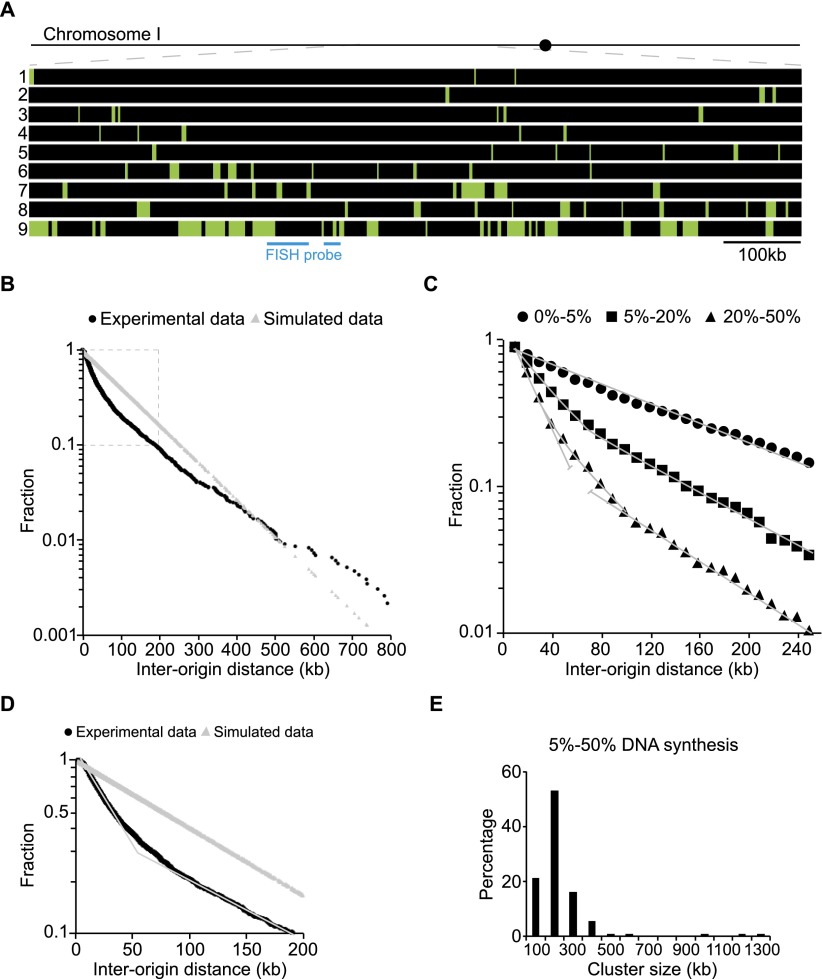
Replication origins both fire stochastically and form clusters. (A) Replication profile of nine completely overlapping 1-Mb single DNA molecules corresponding to the same region on Chromosome I (from 2100 to 3100 kb). (B) Semilog plot of the cumulative frequency of IODs measured for 131 single DNA molecules with an average length of 1.8 Mb and replicated up to 50% (black curve). The values on the y-axis correspond to the fraction of IODs that are larger in size than the corresponding IOD on the x-axis. The gray line corresponds to simulated data for a purely random distribution of the same number of origins over the same DNA length. The experimental measurements deviate significantly from the purely stochastic prediction, P < 0.001 (Lilliefors statistical test). (C) Semilog plot of the cumulative frequencies of IODs for molecules sampled according to their extent of DNA synthesis; black circles, black squares, and black triangles correspond to molecules replicated from 0%–5%, 5%–20%, and 20%–50%, respectively. At the beginning of S-phase, origin selection is random, as the cumulative frequency of IODs for molecules replicated up to 5% fits a straight line. For molecules replicated from 5%–20%, the curve deviates from the straight line at short IODs. The curve corresponding to molecules replicated from 20% to 50% can be decomposed into two straight lines with different slopes. (D) Semilog plot of the data within the dashed box in B, representing 90% of the IODs. The experimental data curve can be decomposed into two straight lines with different slopes (thin gray line), indicative of two regimes of stochastic origin selection operating along chromosomes. (E) Histogram of cluster sizes for molecules replicated from 5% to 50%.